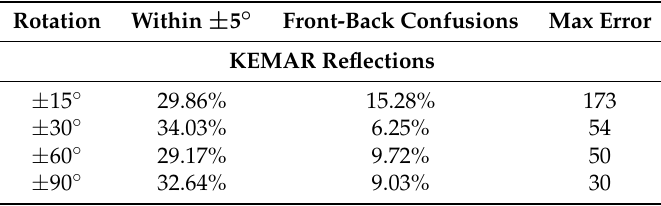
Table 1. Direction of arrival accuracy comparison for the reflected component measured with the KEMAR 45BC for different fixed receiver rotation